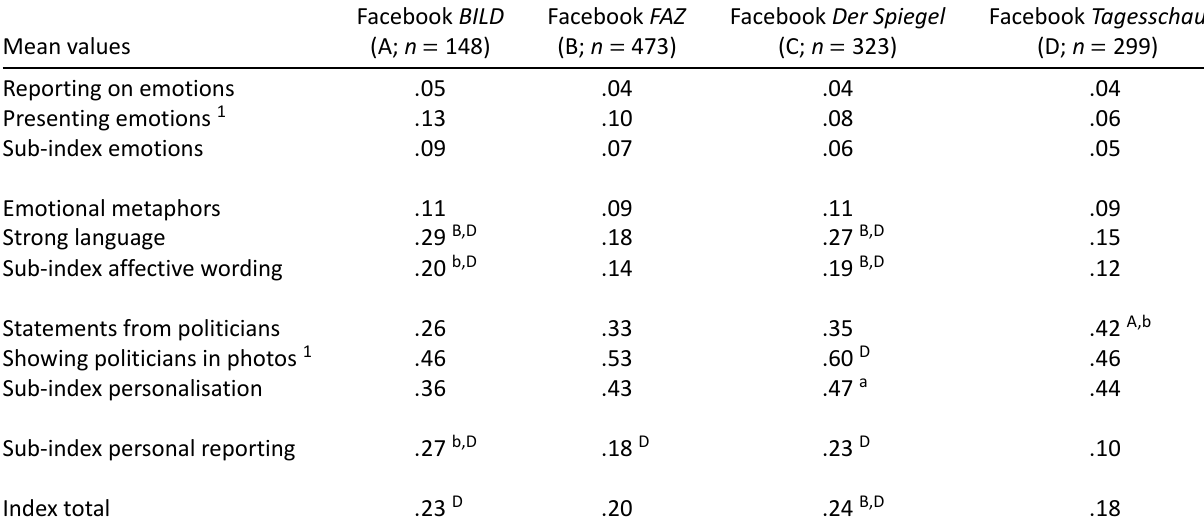
Table 2. Comparison of Facebook posts regarding news